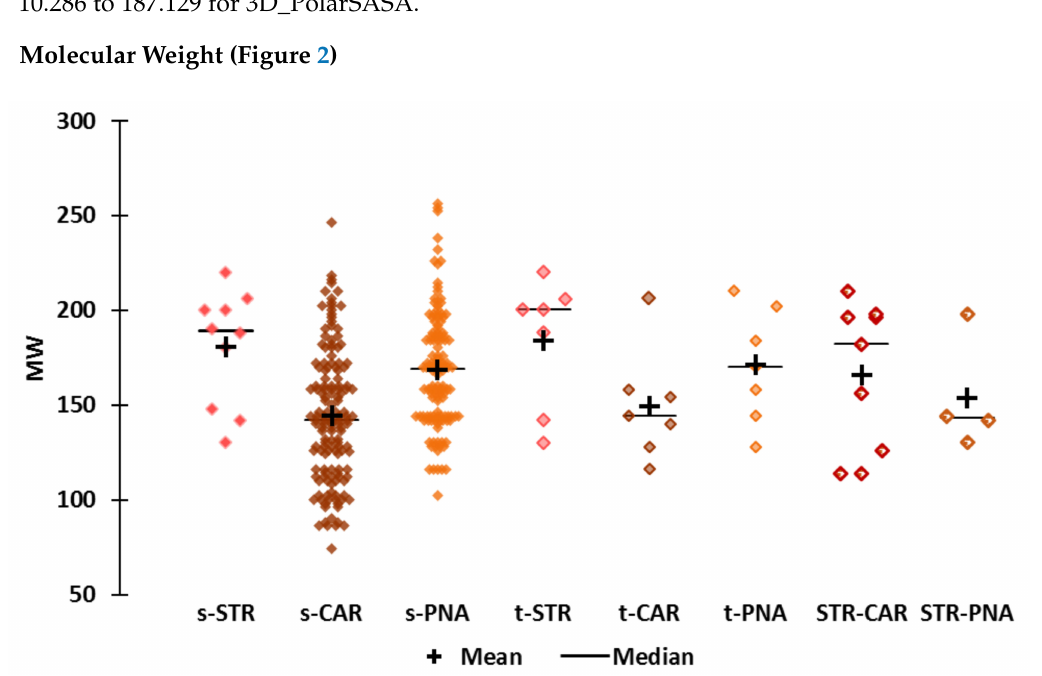
Figure 2. Scattergrams of the MW values by odor